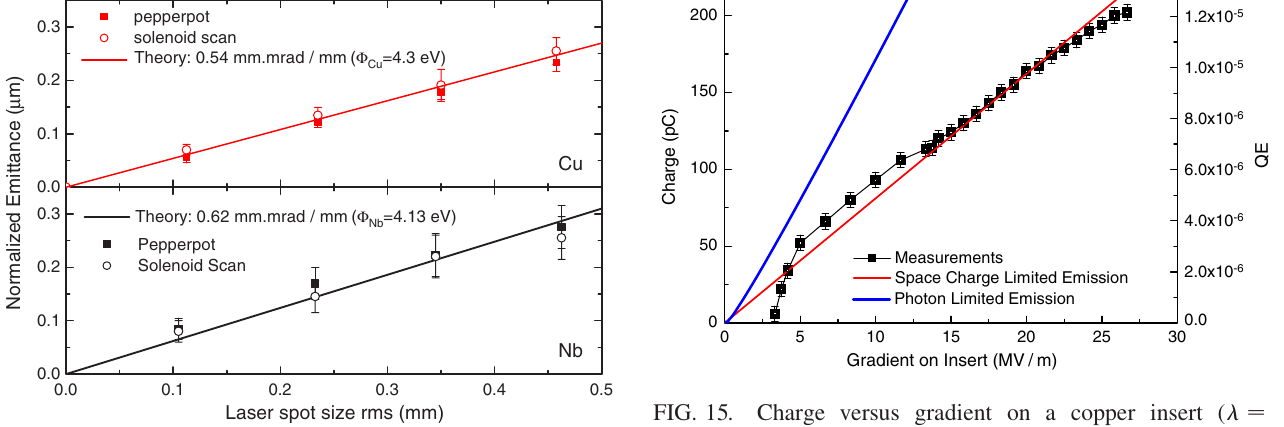
FIG. 14. Normalized projected emittance versus laser spot size (rms) for Cu cathode insert (top) and a (110) Nb cathode insert (bottom)